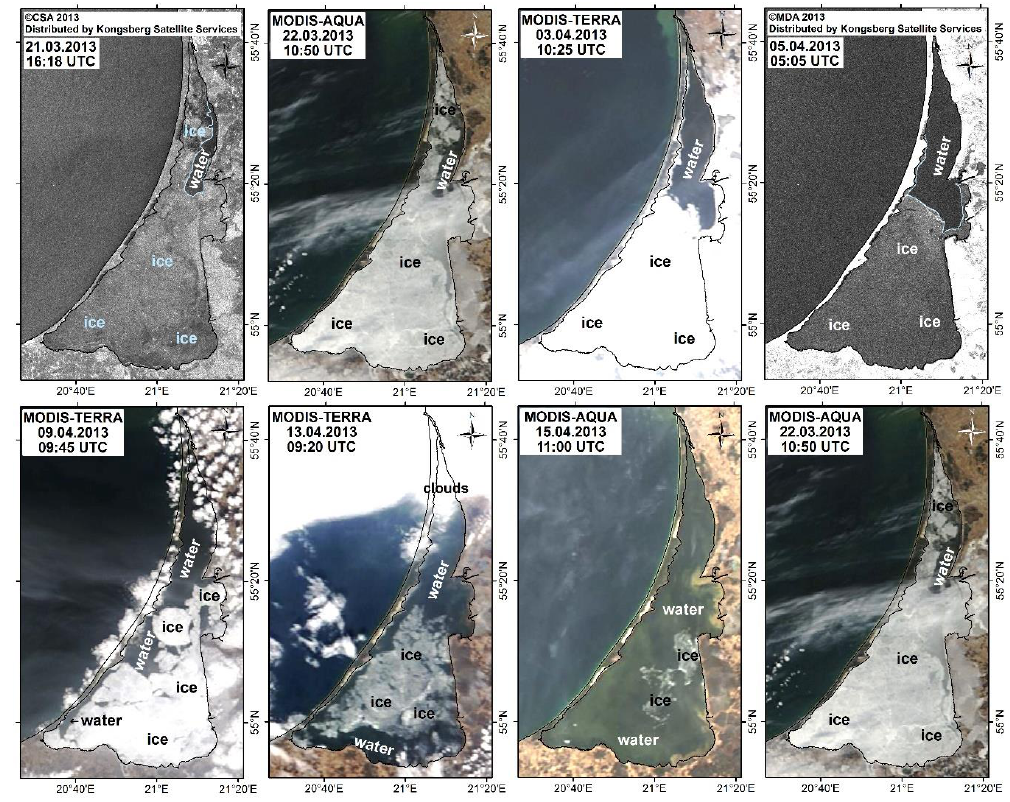
Figure 7. Ice break-up and decay in the Curonian Lagoon in March–April 2013. Light blue contours mark the boundaries between the open water and the ice-covered regions.